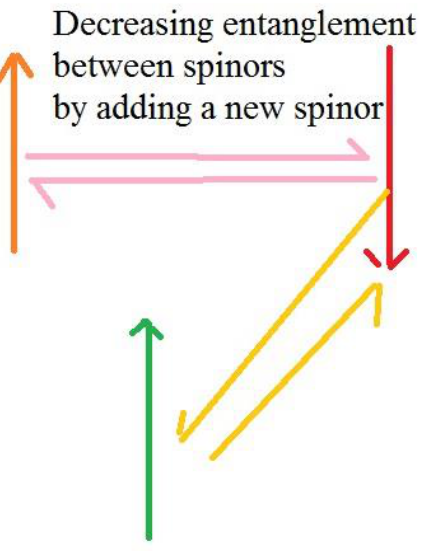
Figure 2. An extra spinor decreases entanglement between two spinors—a hypothesis.